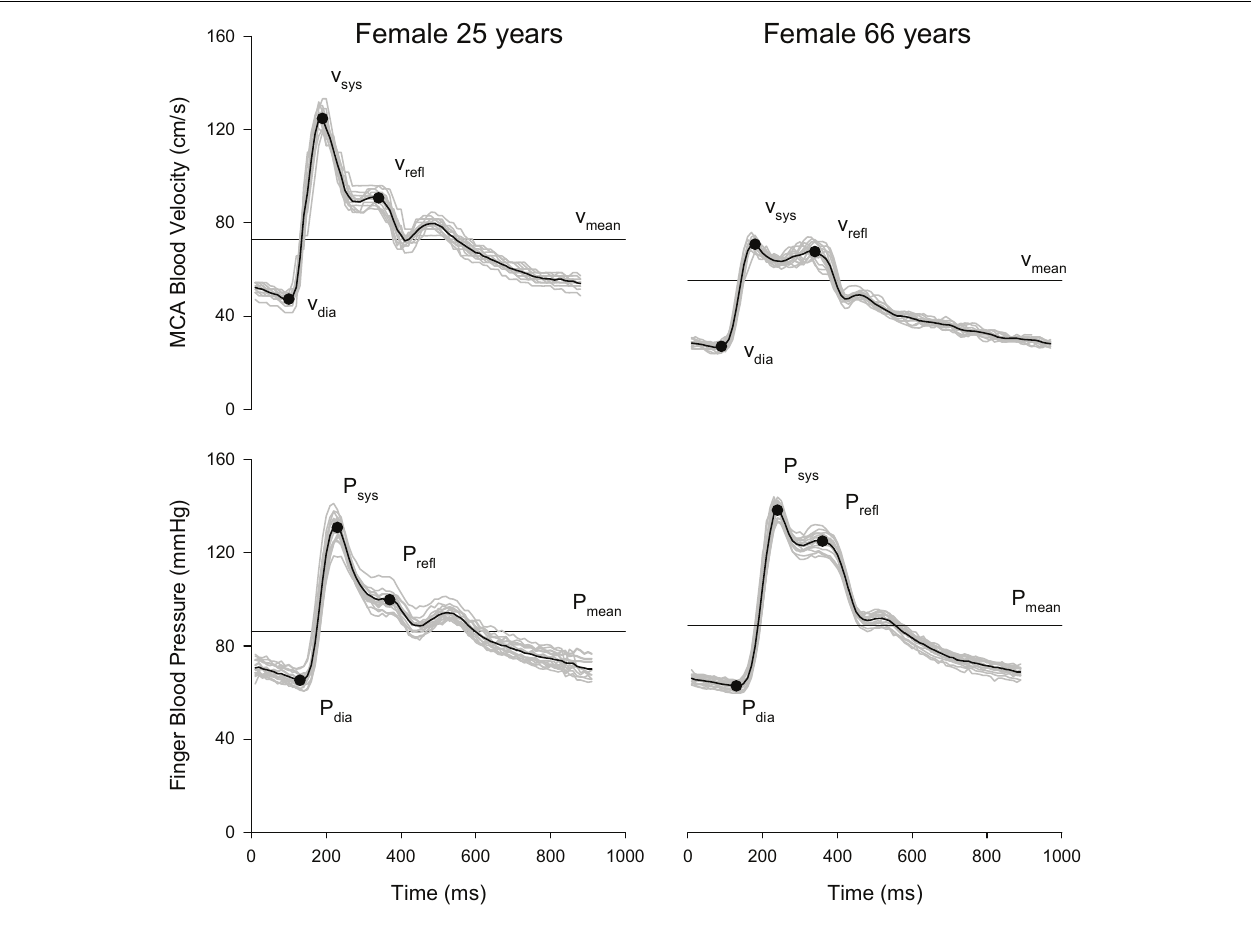
FIGURE 1 | Representative MCA blood velocity and finger blood pressure waveforms of a young (age = 25 years) and older (age = 66 years) volunteer at rest. Each plot shows the overlay